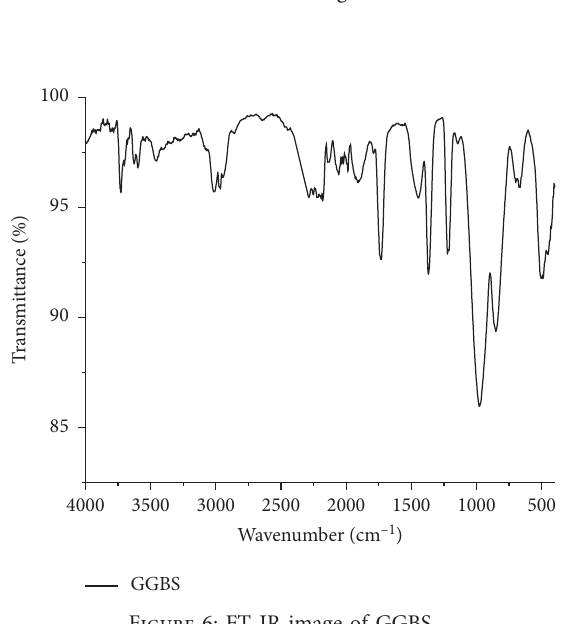
Figure 5: FT-IR image of FA.